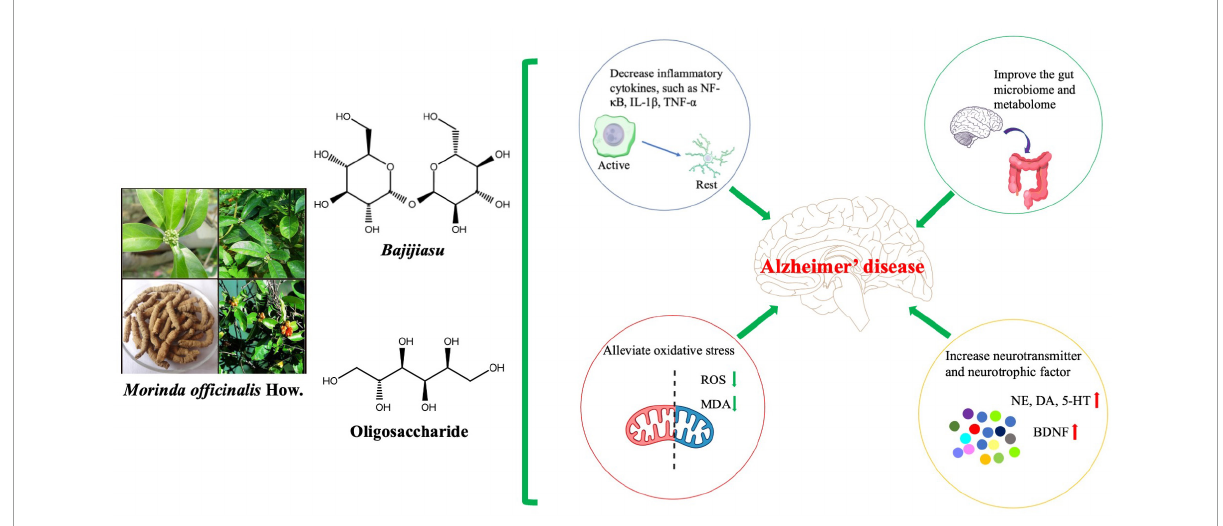
FIGURE3 Antioxidative and Anti-inflammatory activities of Morinda officinalis How. (MO) and its main components. MO may be used to treat Alzheimer’s disease and improve functional behavioral outcomes by reducing oxidative stress, inhibiting inflammatory factors, enhancing the intestinal microbiome and metabolome, and increasing neurotransmitter and neurotrophic factor expression. 5-HT, 5-hydroxytryptamine; BDNF, brain-derived neurotrophic factor; DA, dopamine; IL-1 β , interleukin-1 β ; MDA, malondialdehyde; NE, norepinephrine; NF- κ B, nuclear factor kappa-B; ROS, reactive oxygen species; TNF- α , tumor necrosis factor α